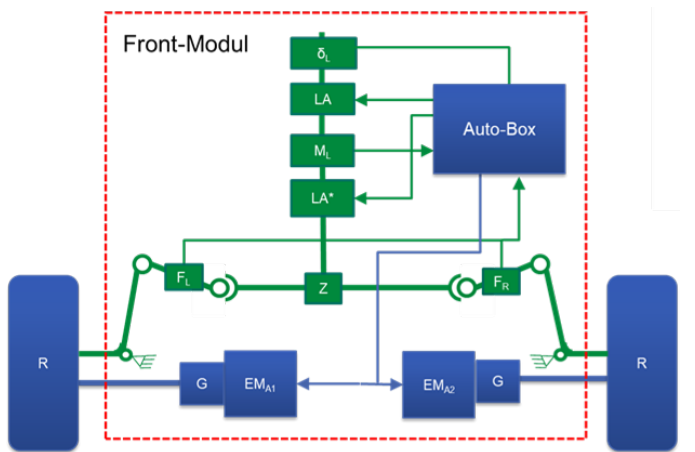
Figure 11. Front model structure of the demonstrator